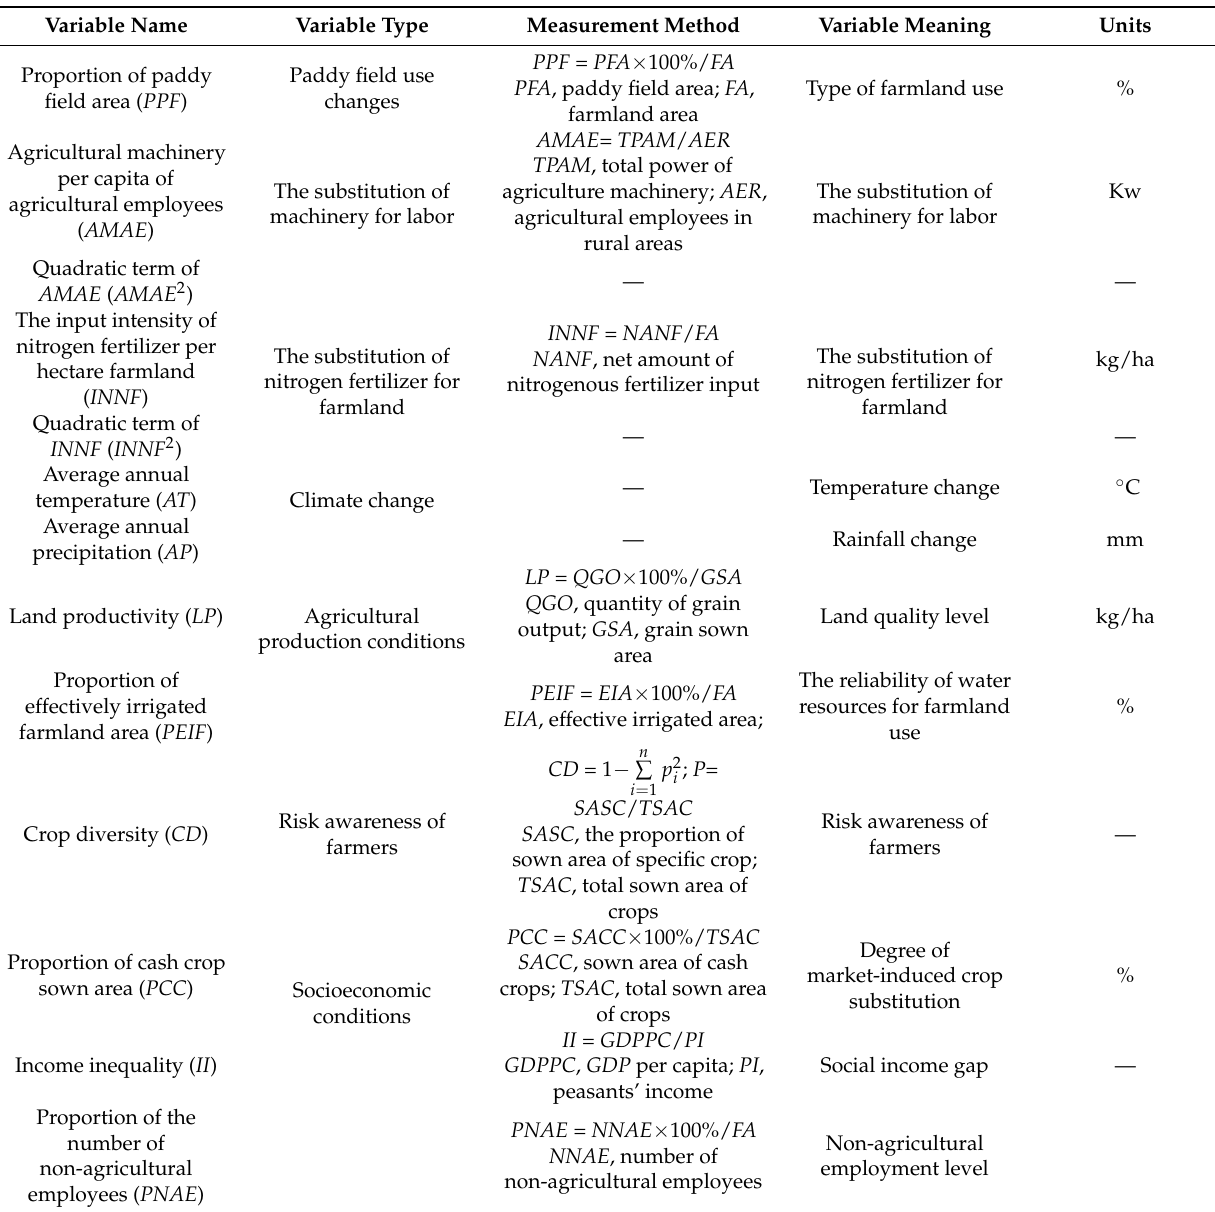
Table 1. Variables and